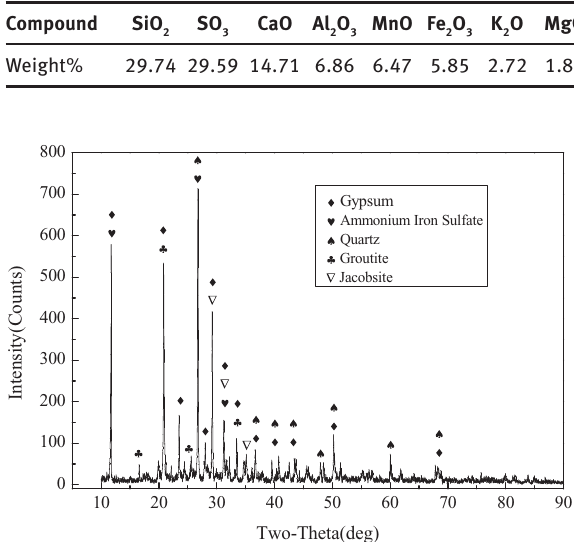
Figure 1: X-ray diffraction pattern of EMR.